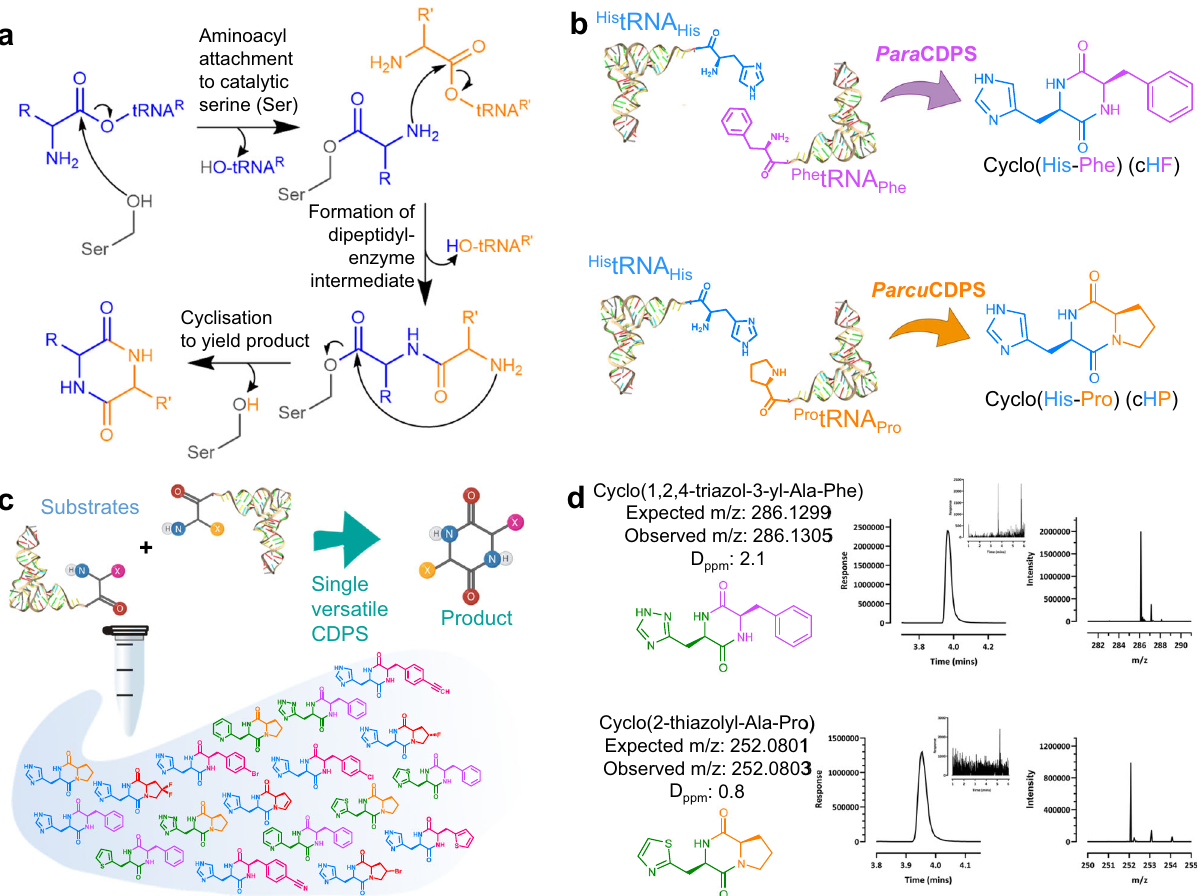
Fig. 1 CDPS mechanism and reaction and products. a General mechanism of CDPS enzymes as elucidated from AlbC 12 – 17 . b Enzymes characterised here, both use aminoacylated tRNAs as substrates to produce a cyclic dipeptide. Para CDPS from Parabacteroides sp. 20_3 (GenBank: EFK64745.1) produces cyclo(L-His-L-Phe), and Parcu CDPS from Parcubacteria bacterium RAAC4_OD1_1 (GenBank: ETB63777.1) can synthesise both cyclo(L-His-L-Glu) – not shown – and cyclo(L-His-L-Pro). c Strategy employed here, using a single enzyme catalyst to produce several cyclodipeptide products; d Representative LC-HRMS spectra showing production of new molecules. The extracted ion chromatogram (EIC) for each is shown with the corresponding mass spectra from each peak. The inset shows an EIC from a control lacking CDPS. Spectra for all cyclodipeptides described here are on SI Figs. 7 and